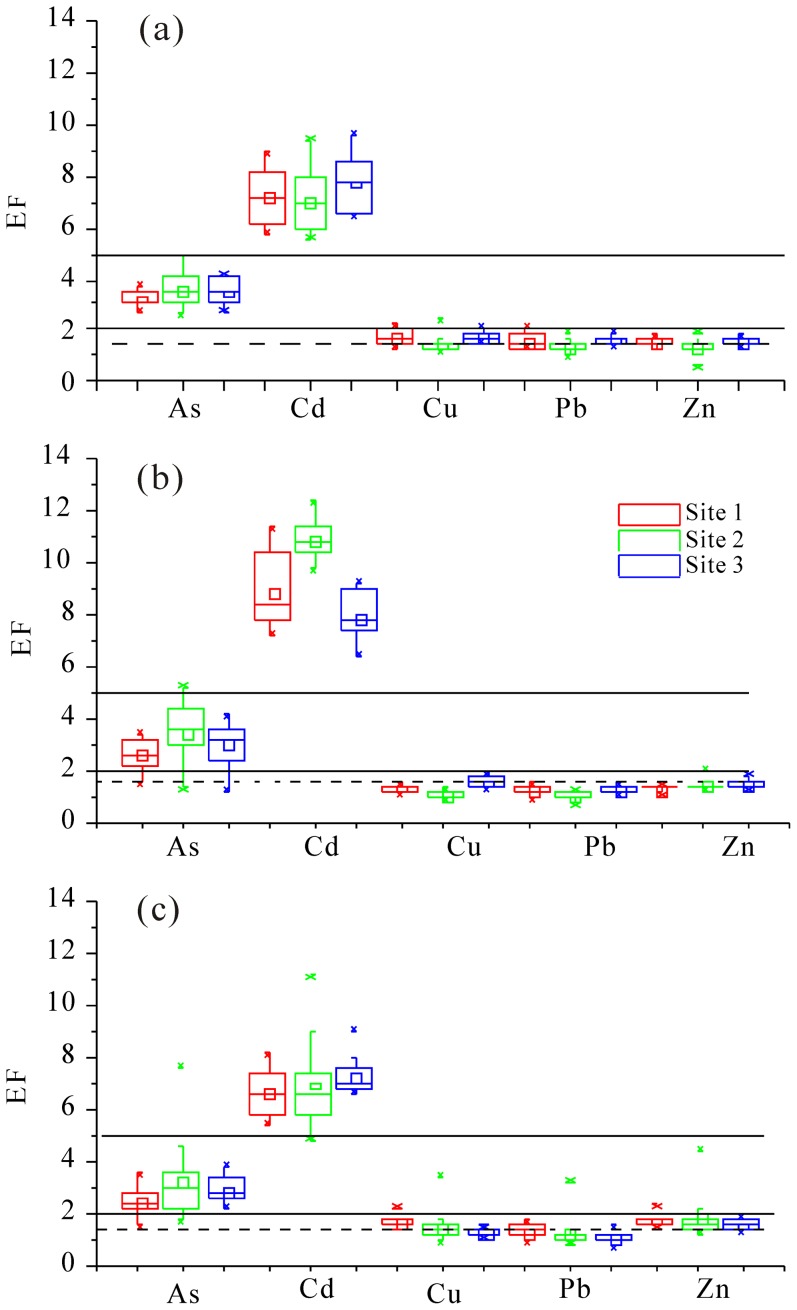
Box-plots of enrichment factors of trace elements in all soil samples of each site of the three in three seasons (a) Spring; (b) Summer; (c) Fall.Straight lines represent the EF = 2 or 5; dash line represents EF = 1.5.